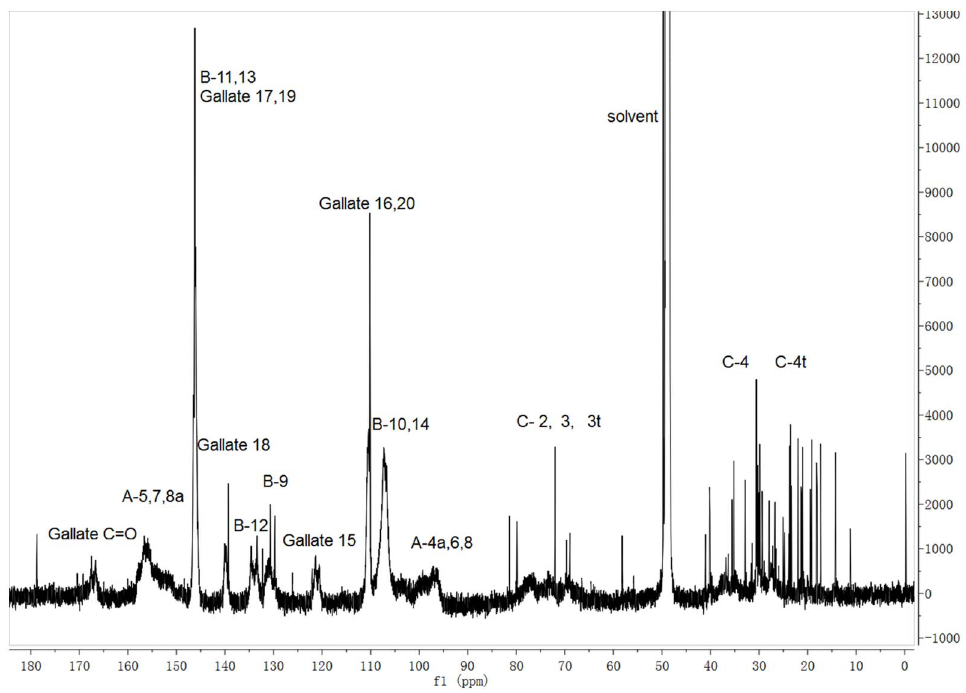
Figure 2. 13 C NMR spectrum of Chinese bayberry leafs proanthocyanidins. Samples were dissolved in methanol- d 4 .